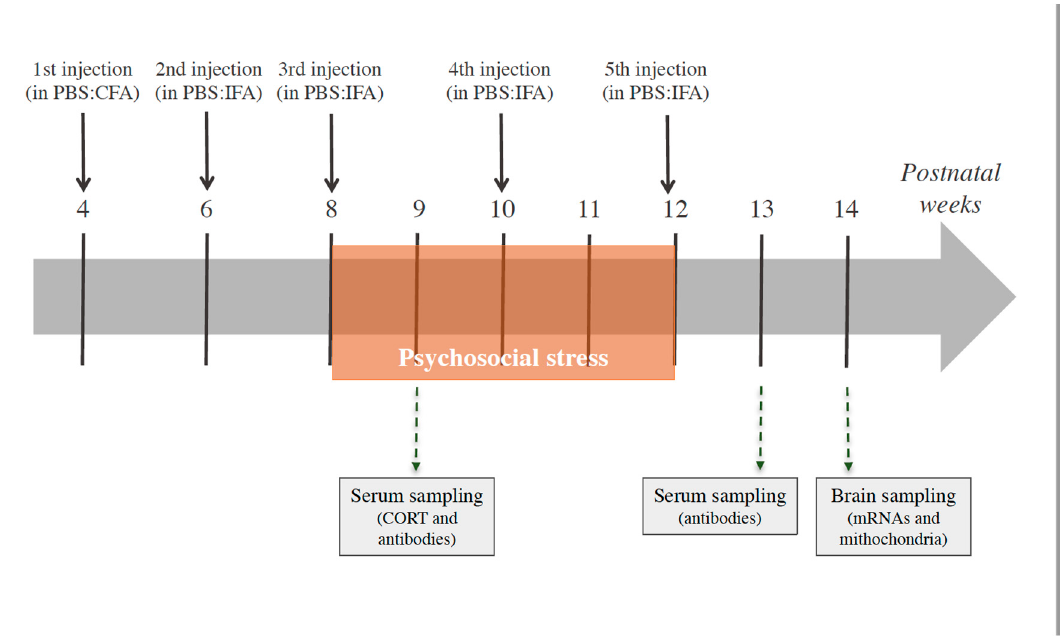
Figure 1. Timing of stress exposure and of the Group-A beta-haemolytic streptococcus (GAS) injections, expressed in weeks, and the experimental procedures performed. Mice (N = 9–10 per group) received 5 injections of GAS homogenate or Phosphate Buffer Saline (PBS), formulated with the indicated adjuvants (CFA = Complete Freund’s adjuvant; IFA = Incomplete Freund’s adjuvant). Serum samples were collected for antibody determination and corticosterone (CORT) concentration assessment; brain samples were collected for mRNA expression and mitochondrial analyses.